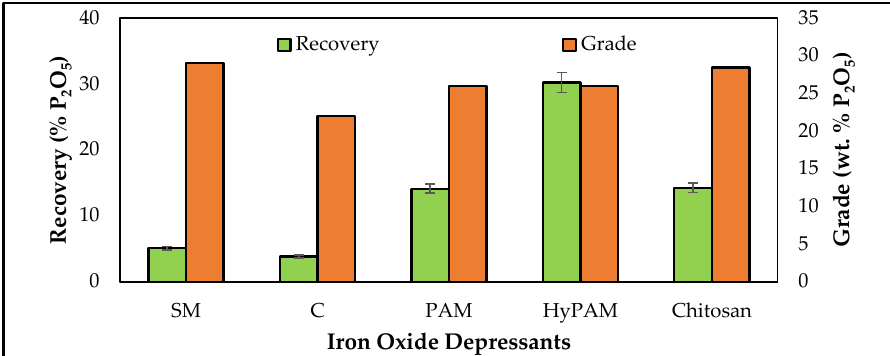
Figure 5. Recoveries and grades of P 2 O 5 in the flotation concentrates when selected iron oxide depressants were used at 500 g/t and pH 9.